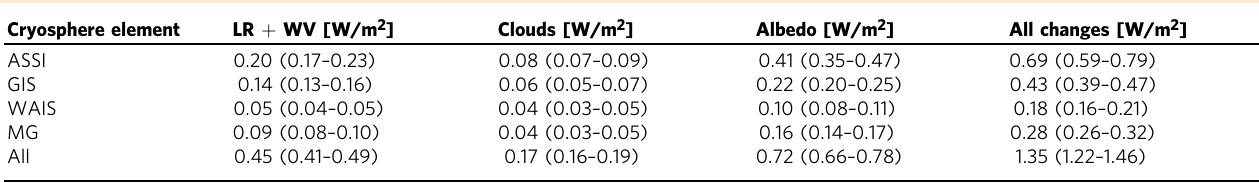
Table 1 Drivers of warming as seen from the top of the atmosphere. Cryosphere element